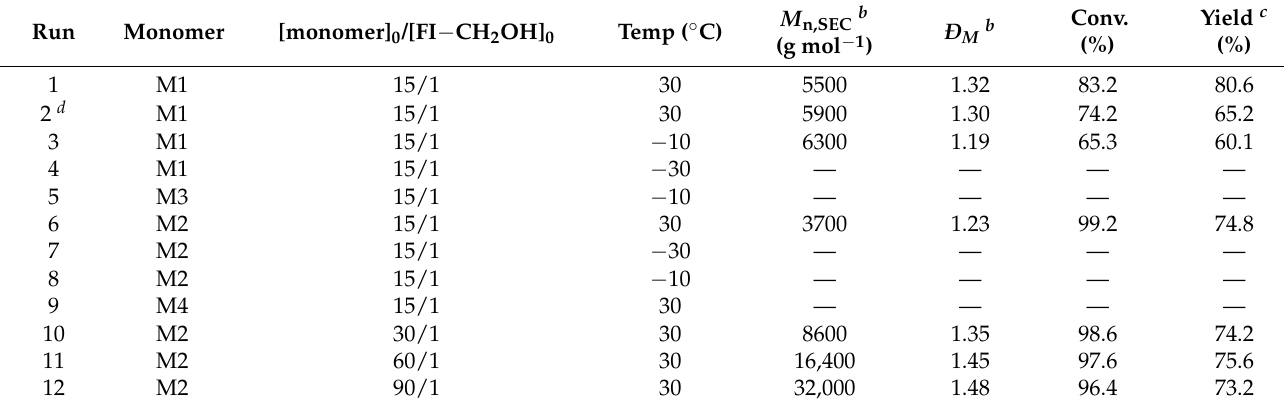
Table 1. SCTP of triolborate-type carbazole monomers under various conditions a .